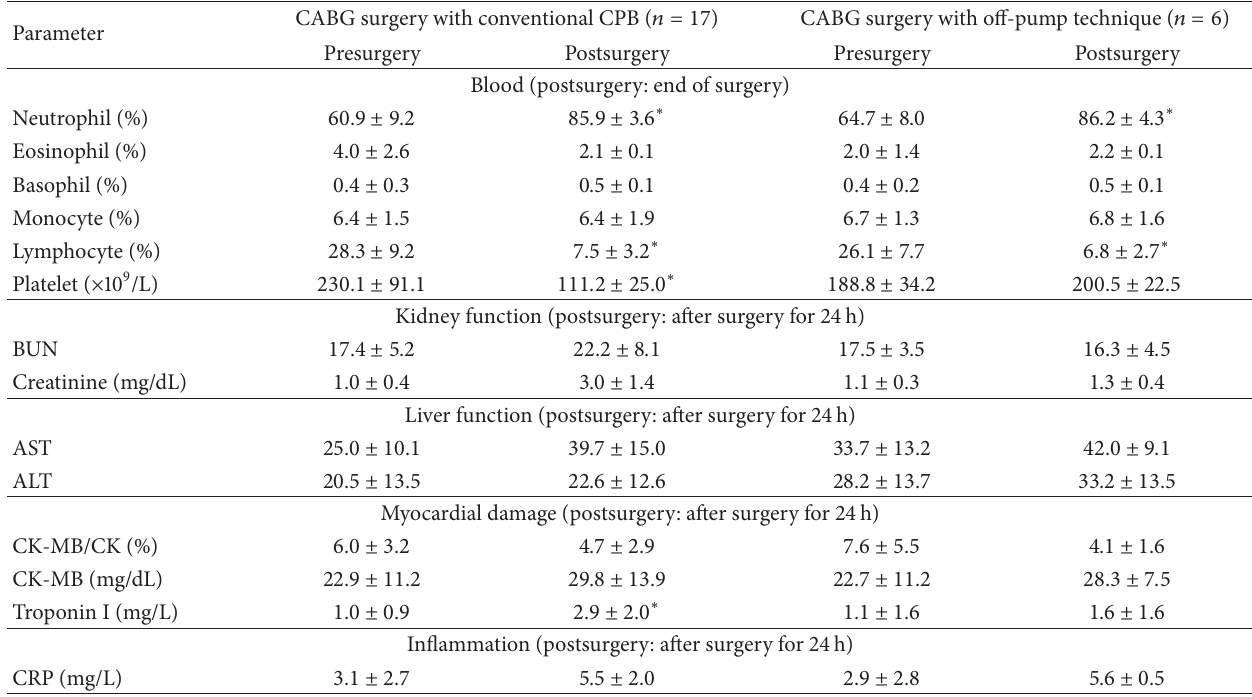
Table 3: Biochemical analyses in elective CABG patients. CABG surgery with conventional CPB ( 𝑛 = 17 ) CABG surgery with off-pump technique ( 𝑛 = 6 ) Parameter Presurgery Postsurgery Presurgery Postsurgery Blood (postsurgery: end of surgery)